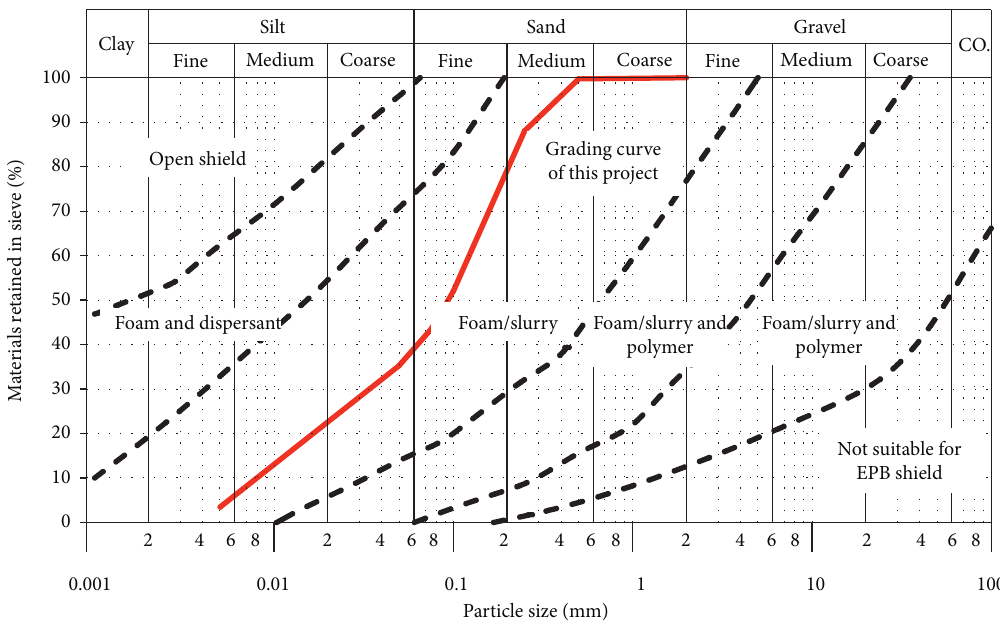
Figure 10: Particle grading curves of soils and suitable conditioning materials. Table 2: Test levels and foaming parameters.